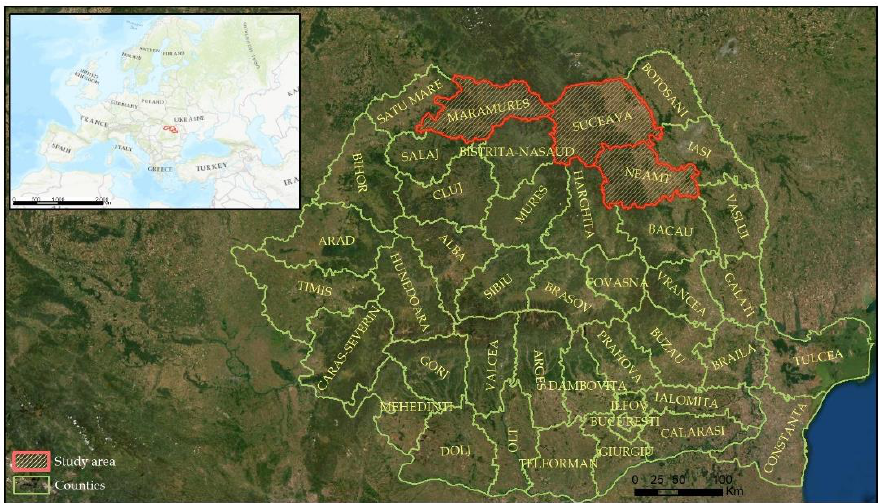
Figure 1. Geographical position of the study area.